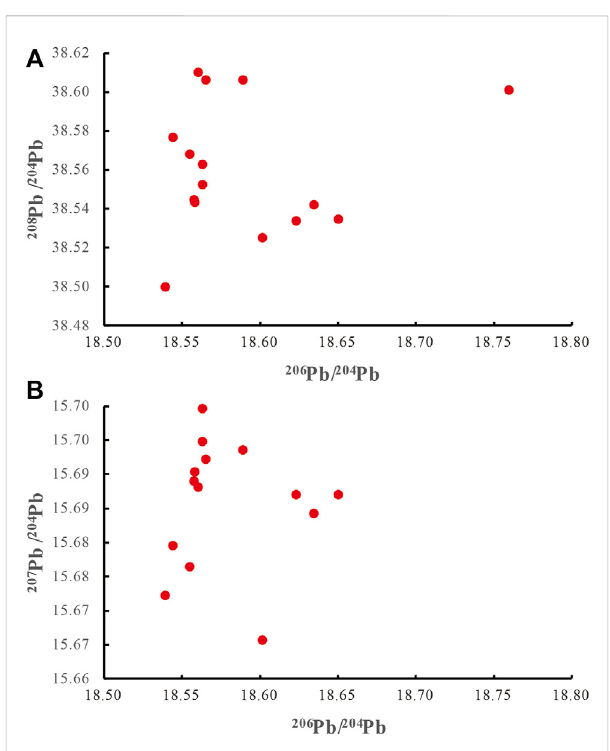
FIGURE 11 Plots of 208 Pb/ 204 Pb vs. 206 Pb/ 204 Pb (A) and 207 Pb/ 204 Pb vs. 206 Pb/ 204 Pb (B) of